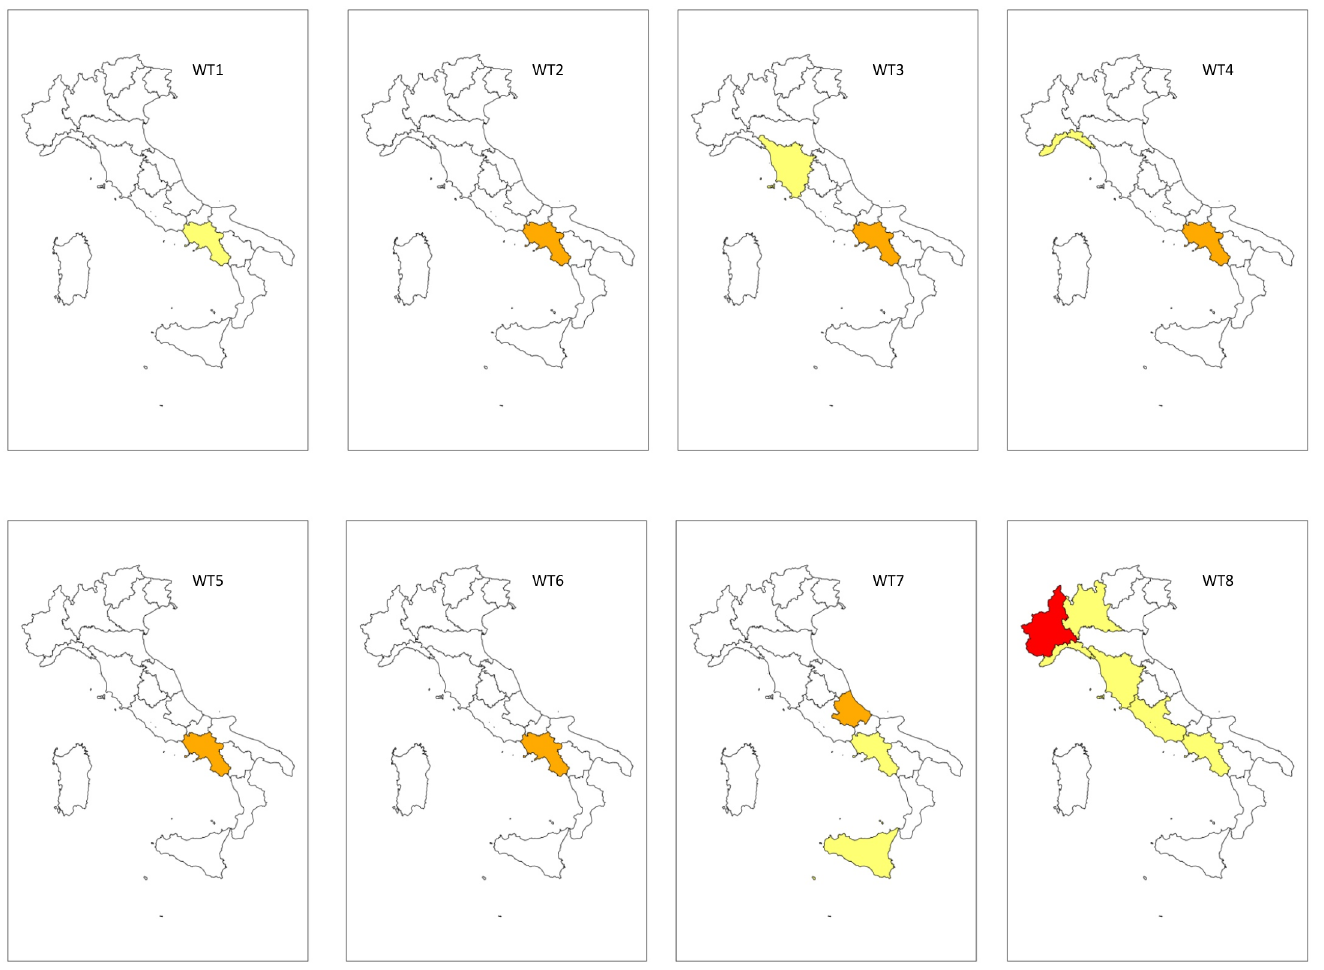
Fig 6. Mapping of the spring WT-related Floods and LAndslides Risk Index (WT-FLARI). WT (Weather Type). WT-FLARI levels: red = Very High (WT-FLARI > 99 th perc.); orange = High (95 th perc. > WT-FLARI > 99 th perc.); yellow = Moderate (95 th perc. > WT-FLARI > 90 th perc.); white = Low (WT-FLARI < 90 th